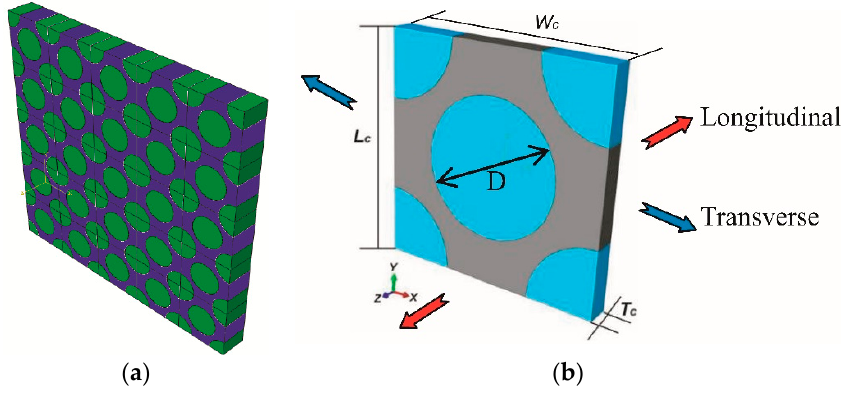
Figure 3. Fiber array pattern model ( a ) and RUC model ( b ).